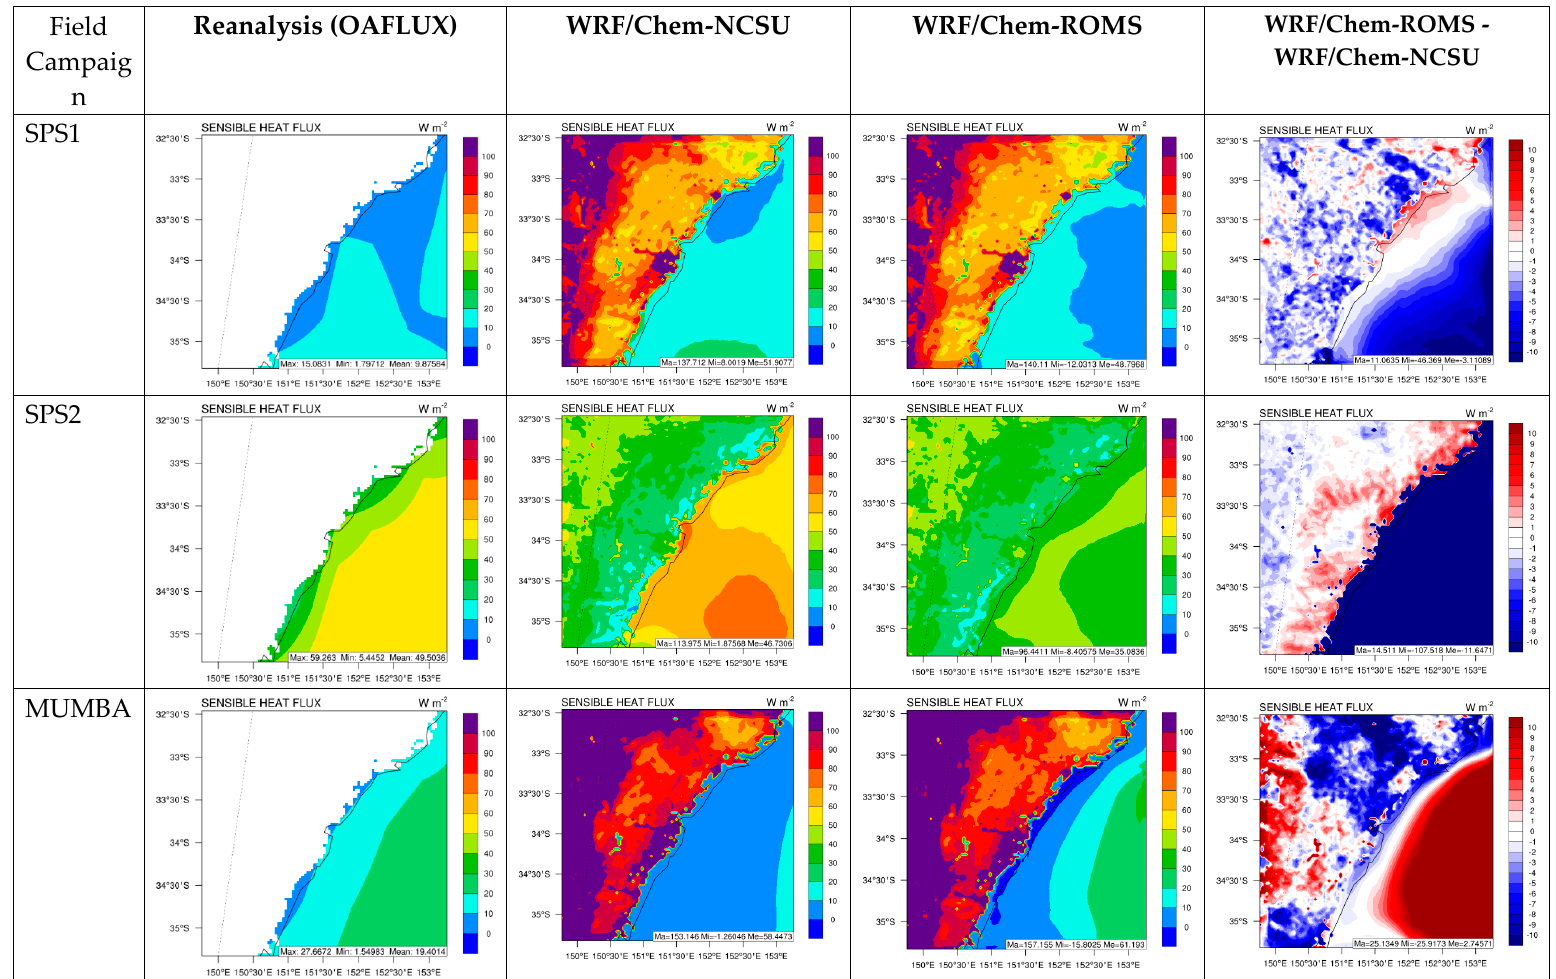
Figure 4. Observed and simulated SHF over the Greater Sydney (d04). Two sets of simulation results at 3 km are compared, one from WRF/Chem-NCSU and one from WRF/Chem-ROMS.